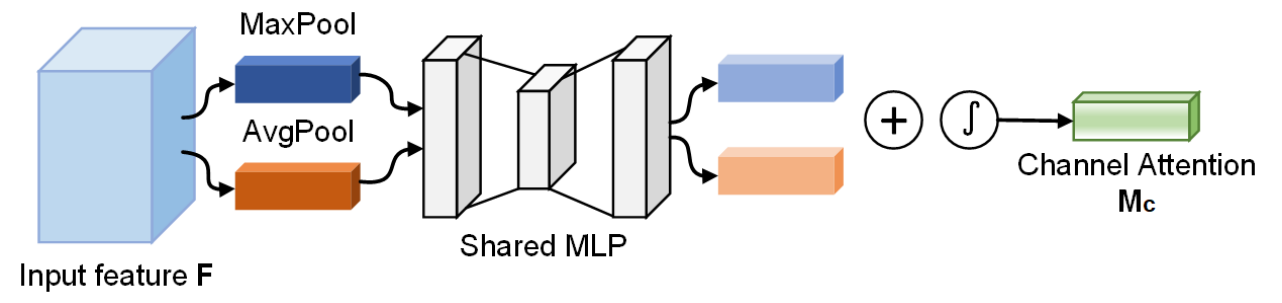
Figure 5. Channel attention